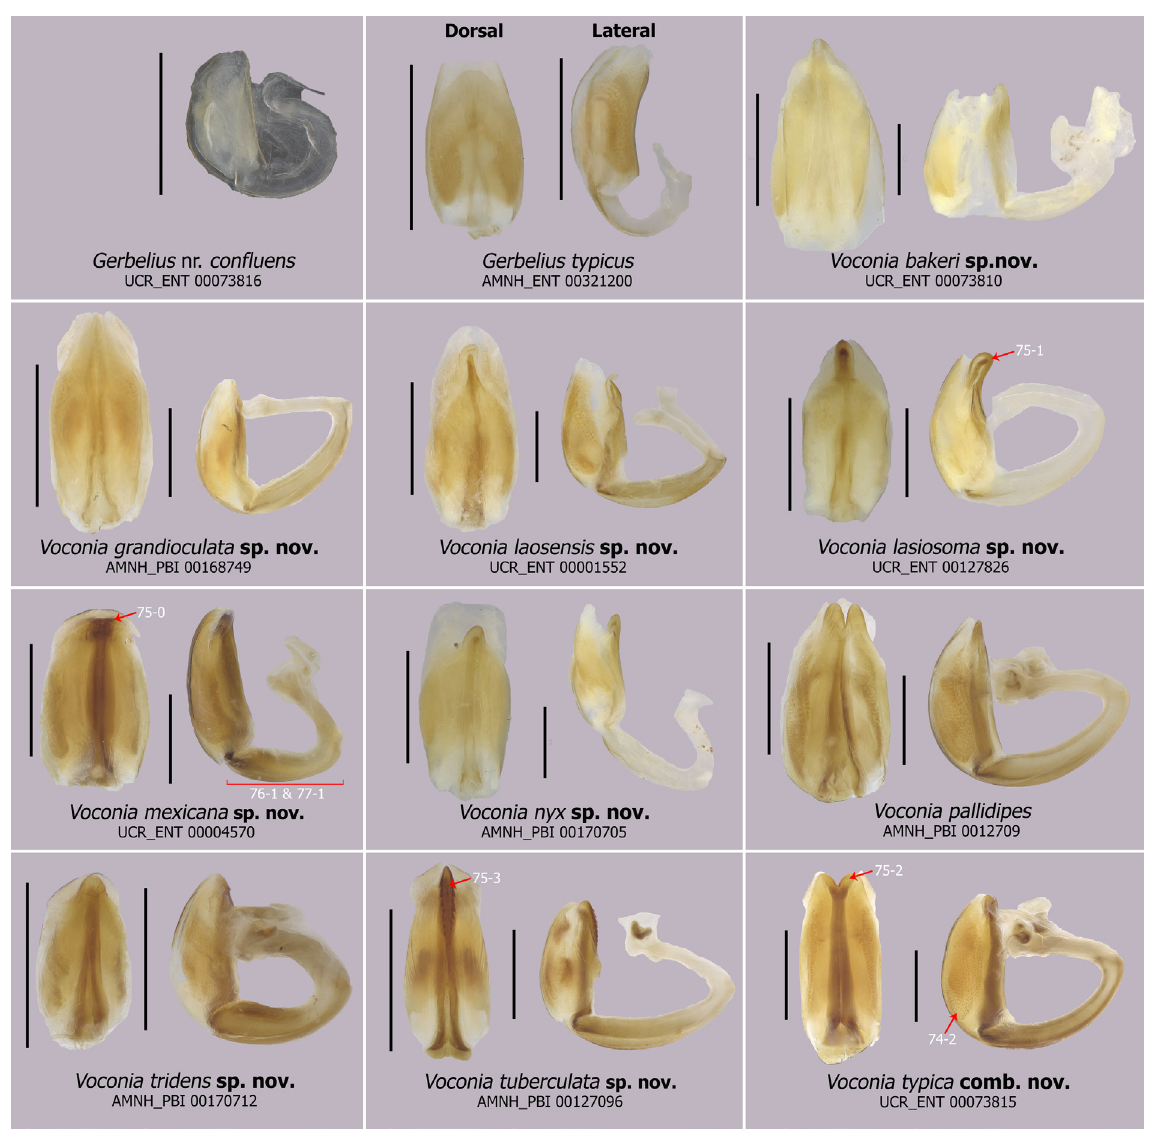
Fig. 14. Aedeagus of species of Gerbelius Distant, 1903 and Voconia Stål, 1866. Scale bars = 0.5